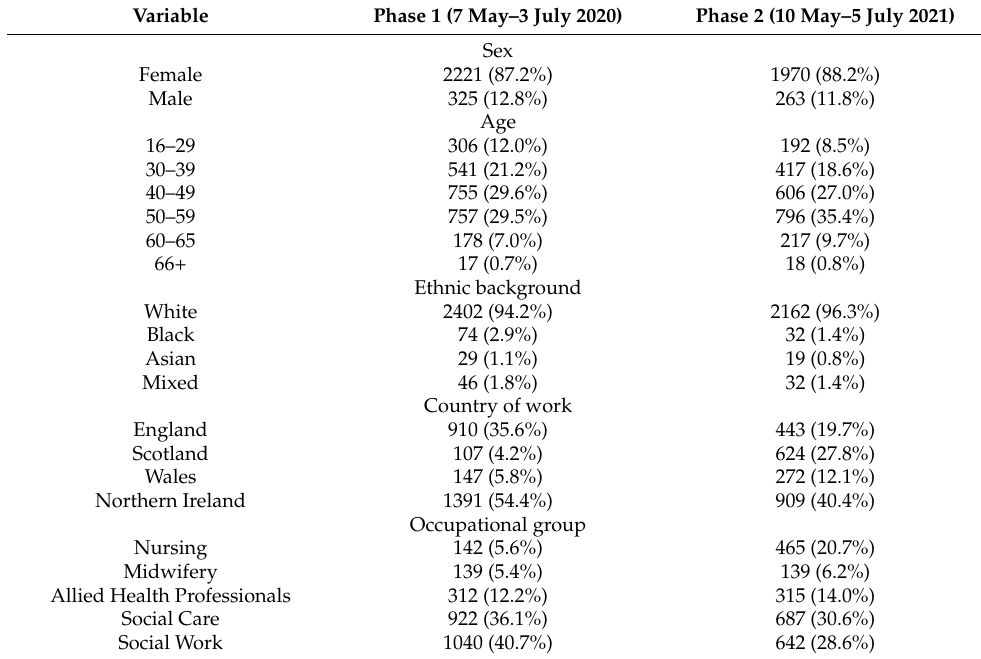
Table 1. Demographic and work-related characteristics (Phase 1: n = 2555; Phase 2: n = 2248).